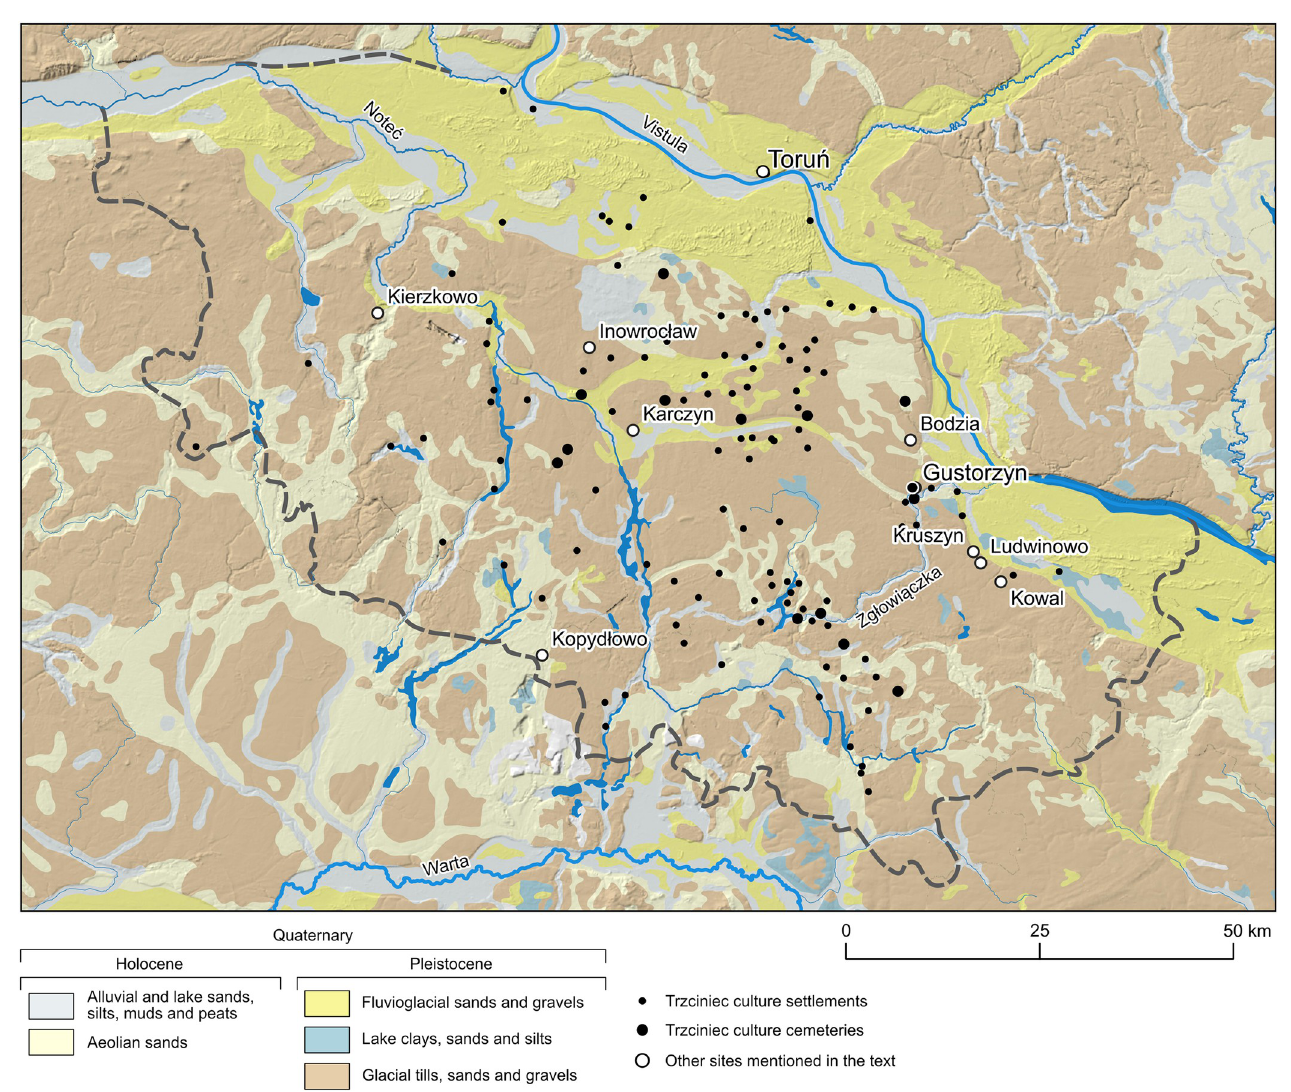
Fig 4. Geological map of Kuyavia with location of the Gustorzyn site, other cemeteries and settlements of the Trzciniec cultural circle societies, and other sites mentioned in this study. The map was produced with the QGIS 3.26.0 software, based on data from the Geological Map of Poland [129], and on data downloaded from https://www.hydrosheds.org/products/hydrorivers (License Agreement) and https://geoportal.gov.pl. Borders of Kuyavia and at the same time the area systematically surveyed by archaeologists is marked by grey dashed